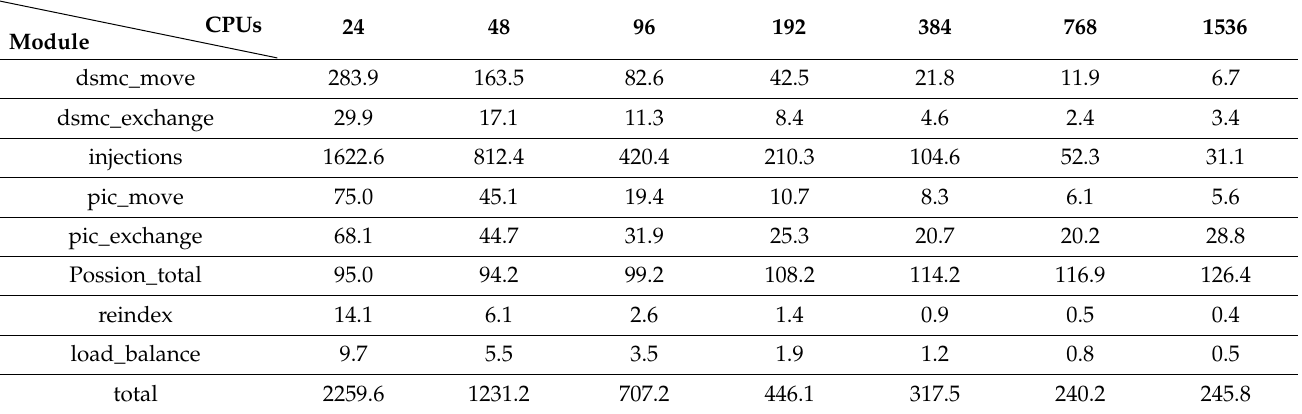
Table 5. Time (unit: s) consumed for parallel computing in the distributed communication